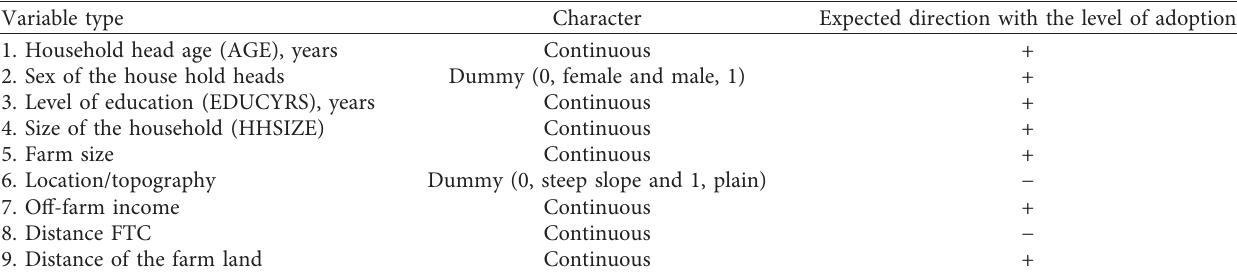
Table 3: The explanatory variables, unit of measurement, character, and expected signs.